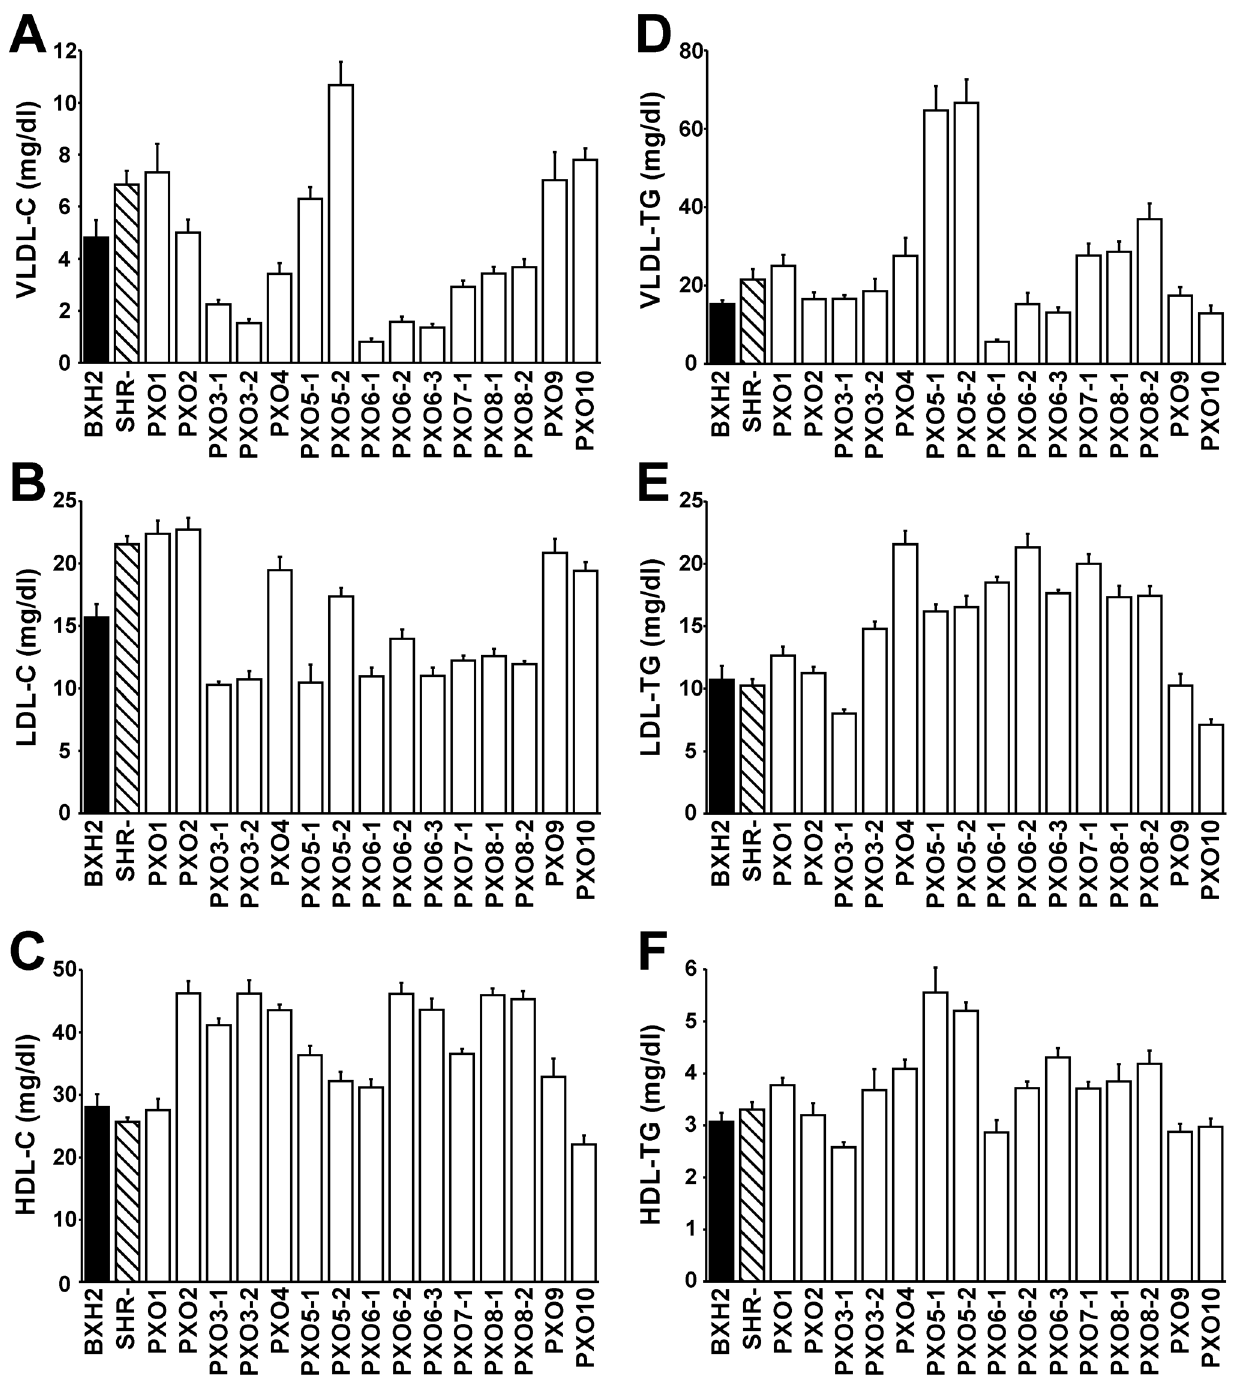
Figure 3. Strain distribution pattern for fasting concentrations of cholesterol (C) and triglyceride (TG) in very low-density lipoprotein (VLDL, panels A, D); low-density lipoprotein (LDL, panels B, E); high-density lipoprotein cholesterol (HDL, panels C, F). Values are shown as means ± S.E.M. for adult male rats of BXH2 (n=18, black bar), SHR- Lx (n=13, striped bar) and all 15 PXO recombinant inbred strains (n=8–13/strain, white bars).